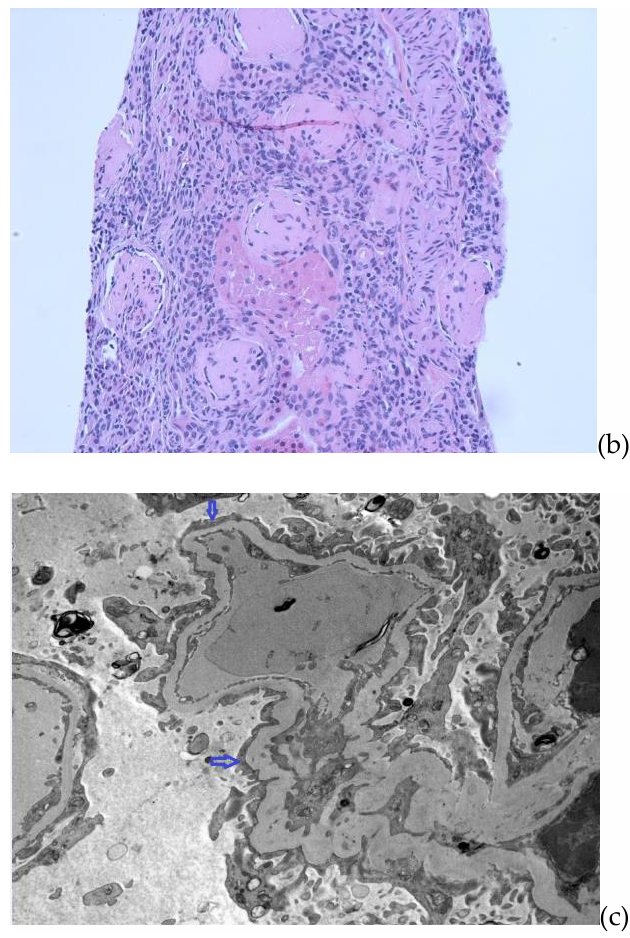
Figure 1. ( a ) Renal biopsy. Light microscopy (H&E) showing a glomerulus with sclerosis in majority of the glomerular capillary tuft, associated with podocyte hyperplasia and foam cells. ( b ) Renal biopsy. Light microscopy (H&E) showing global glomerulosclerosis in the glomeruli with interstitial inflammation in the areas of tubular atrophy and interstitial fibrosis. ( c ) Renal biopsy. Electron microscopy with arrows showing focal areas of podocyte foot process effacement.